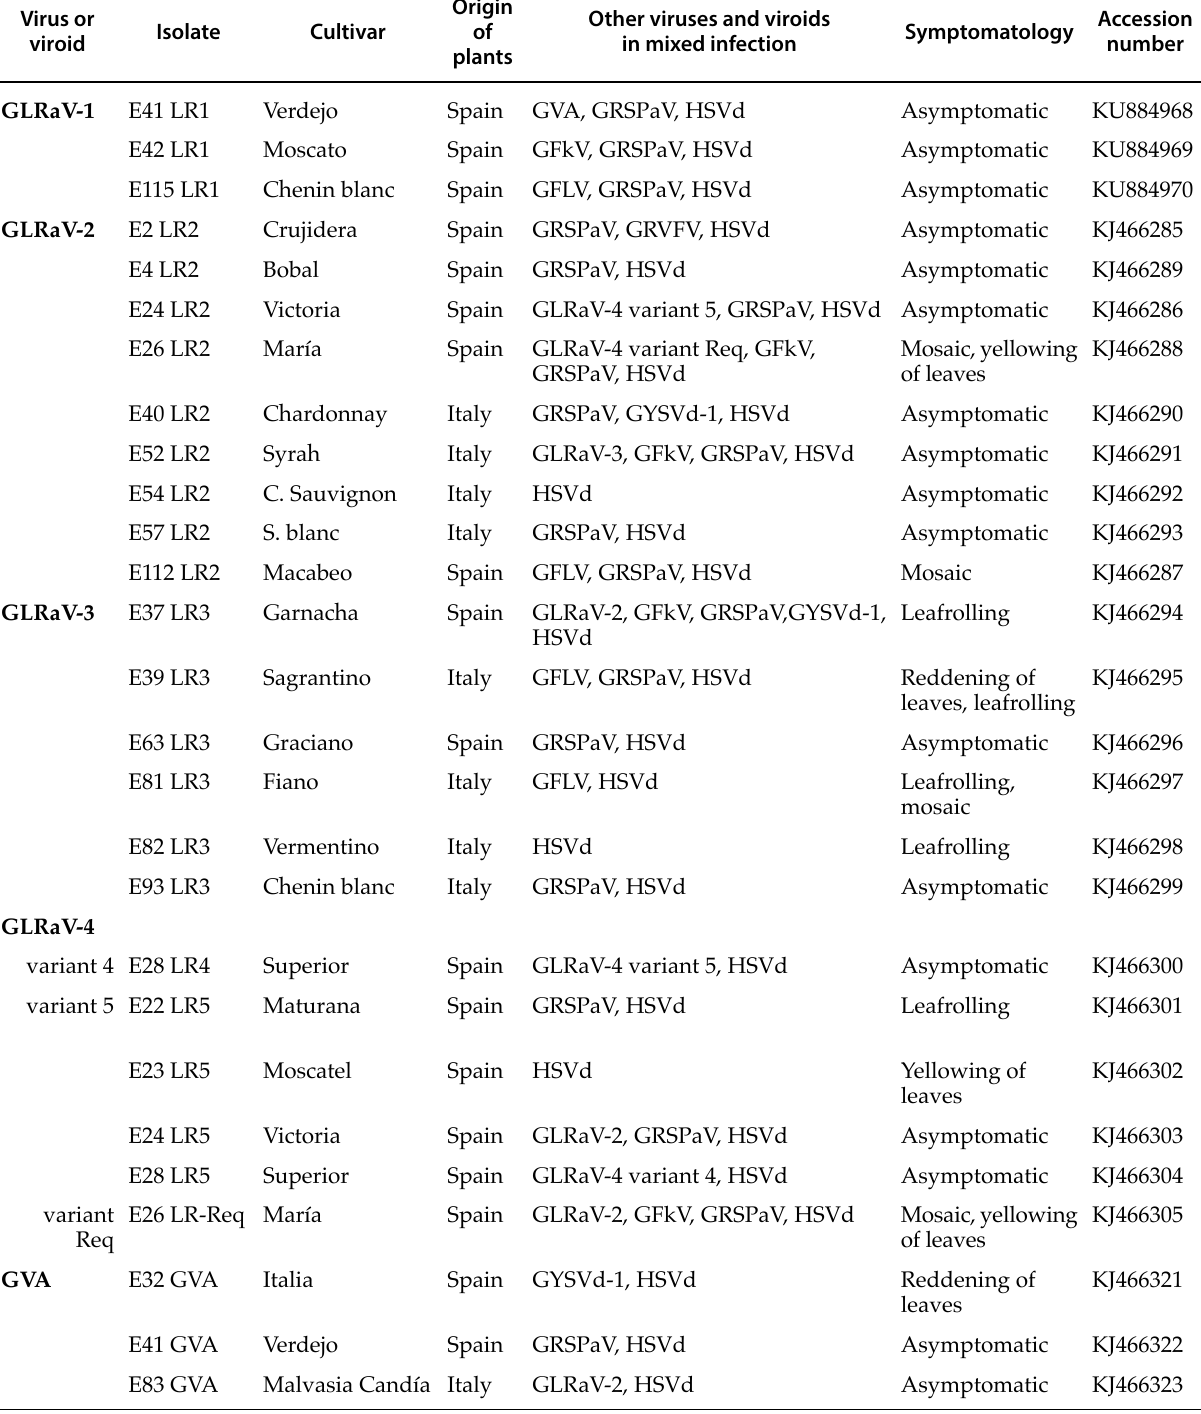
Table 3. Spanish isolates used for phylogenetic